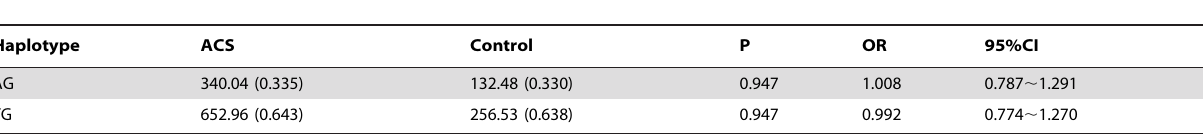
Table 4. Haplotype frequencies of ALOX5AP genetic